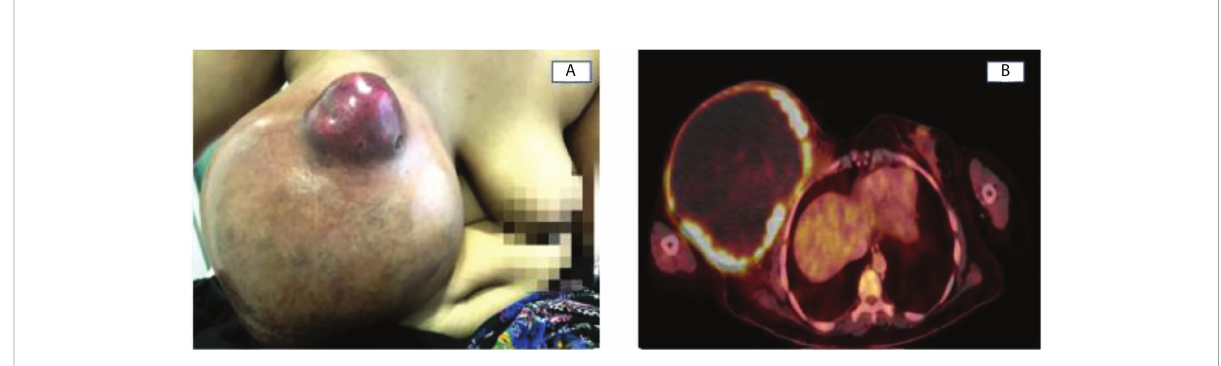
FIGURE 1 (A) Enlarging right breast cancer with a painless, ulcerated, hard, irregular mass in the union of the upper quadrants. (B) Voluminous hypermetabolic mass of 18.4x15.6cm, with a cystic component in the right breast and a SUVmax